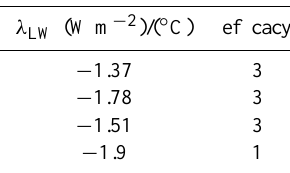
Fig. 16. Annual mean difference in 2m reference temperature due to particulate impurities in snow and sea ice (a) , and due to doubled carbon dioxide (b) . The same to forcings are compared for the response in snow water equivilent ( (c) and (d) ), and for sea ice thickness difference (e) and (f) . Values may be saturated in some cases so that the same scale could be used for a given field. Table 3. Shortwave (SW) and longwave (LW) climate feedback and